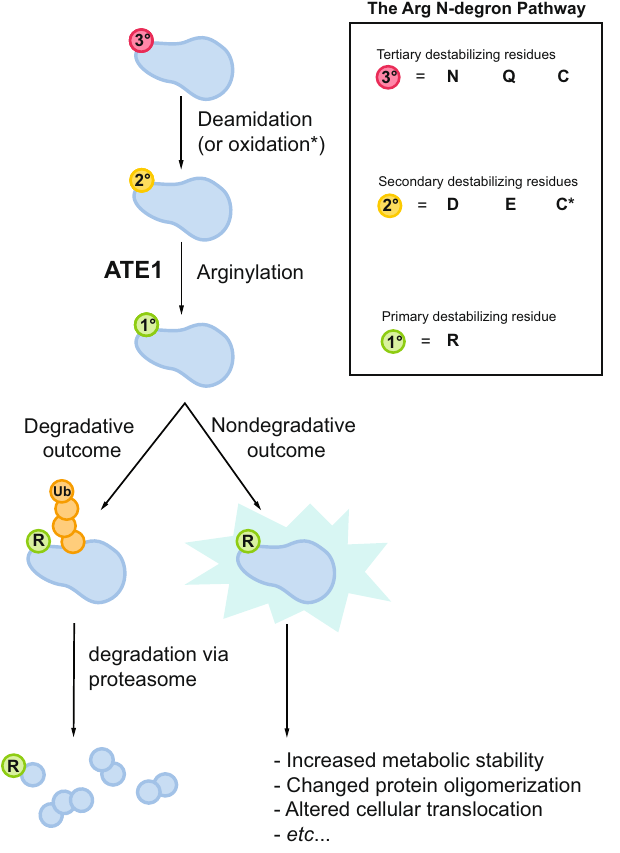
Fig. 1 | Post-translational arginylation is an important degradative and non- degradative post-translational modi fi cation. One function of arginylation is in theeukaryoticArgN-degronpathway,ahierarchicalpathwaythatcontrolsthefate of many proteins in the cell. Tertiary destabilizing residues (red circles) are N-terminalAsn,Gln,and/orCysresiduesthatareexposeduponproteinprocessing. These residues are modi fi ed via deamidation or oxidation to form the secondary destabilizingresidues(yellowcircles)Asp,Glu,and/oroxidizedCys(C*).Secondary destabilizing residues are recognized by arginine transferases (ATE1s), which enzymatically transfer Arg to the N-terminus of a polypeptide, resulting in the exposure of a primary destabilizing residue (green circle), that can be recognized by N-recognins, polyubiquitinated, and broken down in a proteasomal manner. Another important function is nondegradative arginylation, in which arginylated substrate polypeptides may have altered stability, oligomerization, cellular trans- location, and even